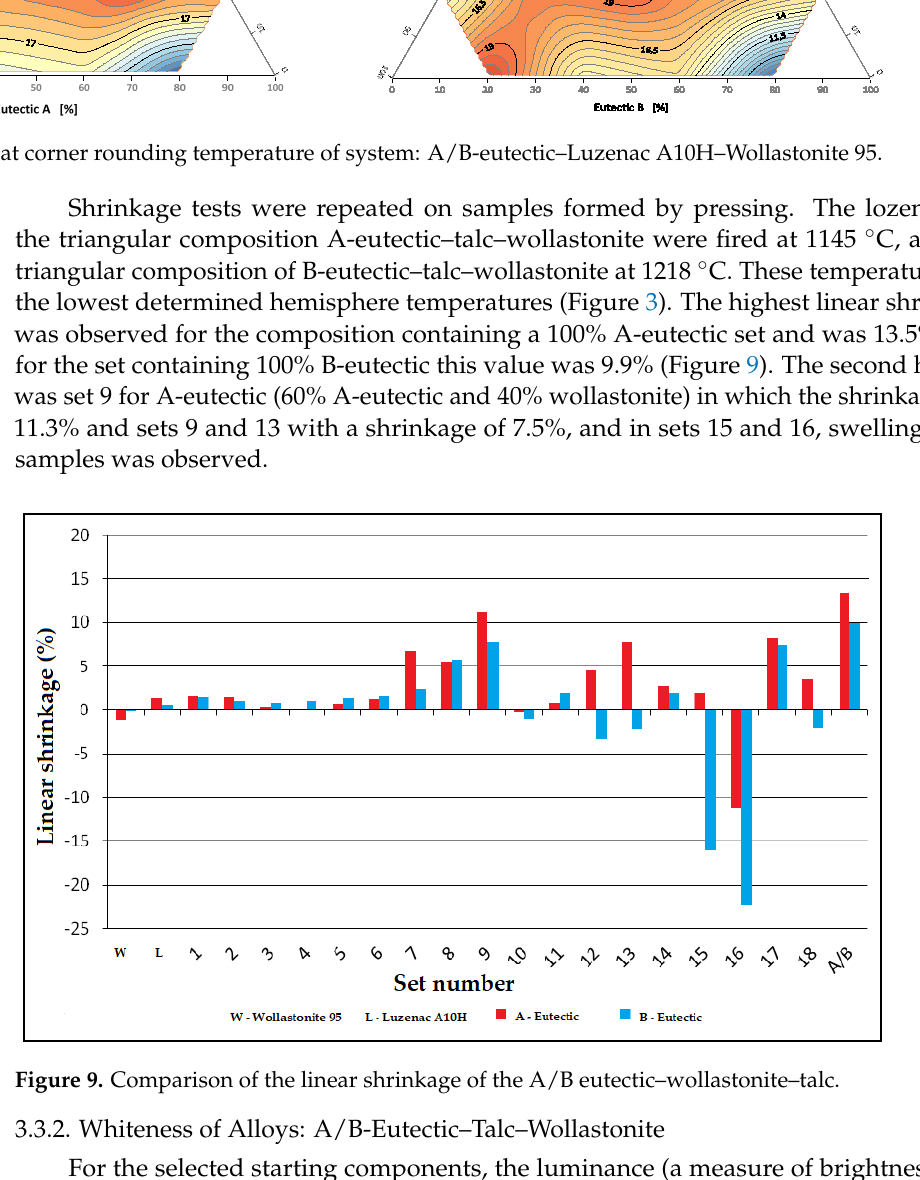
Figure 10. Whiteness of the system A/B-eutectic–talc–wollastonite. From the obtained data, it can be read (Table 5) that the highest value of the color parameter L = 94.49% was registered for the sample No. 1 with the composition of 80% Wollastonite 95 and 20% Luzenac A10H (the sample does not contain a Li–Na–K mixture in its composition), and the lowest value of 72.45% for the composition of 18 B-eutectic. The whiteness depends on the degree of sintering of the sets and their compositions. The measurements showed the highest whiteness for the sets containing increased amounts of wollastonite. Furthermore, talc clearly improves the whiteness. In general, the lower the degree of sintering, the higher the whiteness.